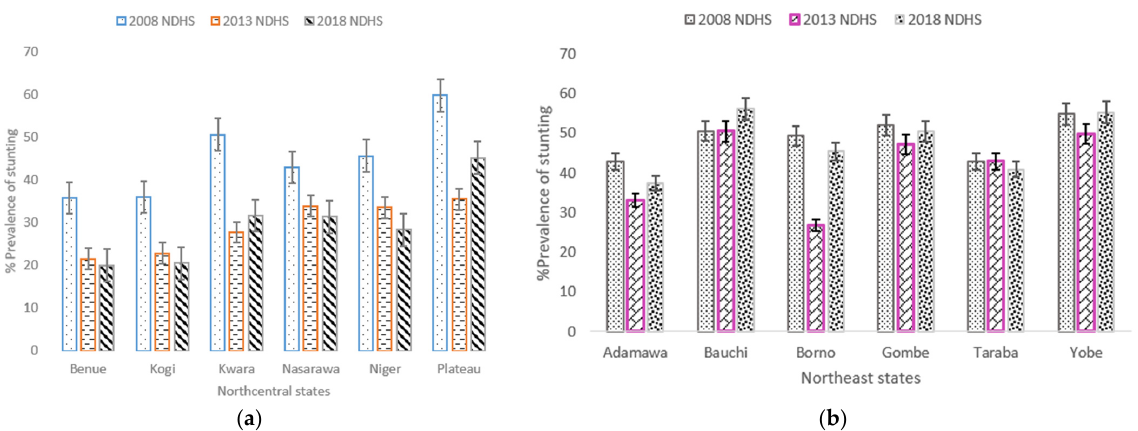
Figure 4. ( a ) Trends in prevalence of stunted children aged 0–59 months, with 95% confidence interval by Northcentral states 2008–2018; ( b ) Trends in prevalence of stunted children aged 0–59 months by Northeast states. Notes: If 95% confidence interval (CI) bars do not overlap, it implies that the difference is statistically significant ( p –value < 0.05).